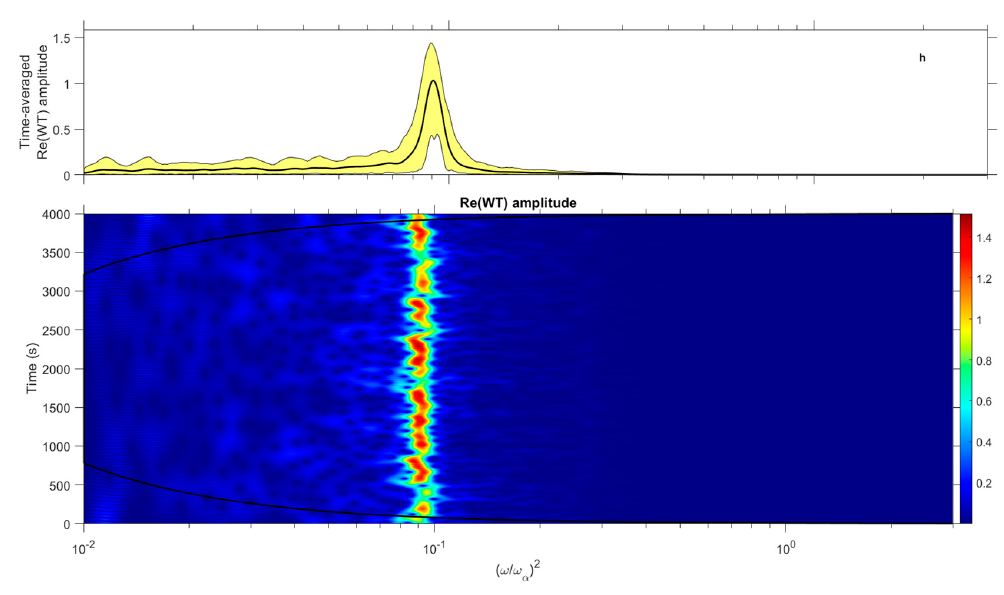
Figure 31. Time–frequency analysis ( ℎ , open-loop, ν = 1 ). Fluids 2020 , 5 , x FOR PEER REVIEW 28 of 34